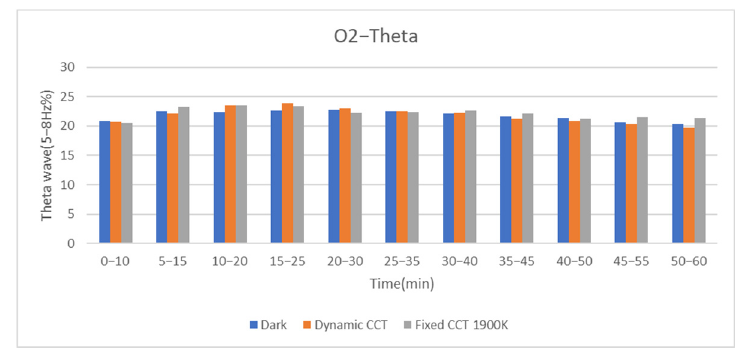
Figure 21. O2 θ wave analysis.